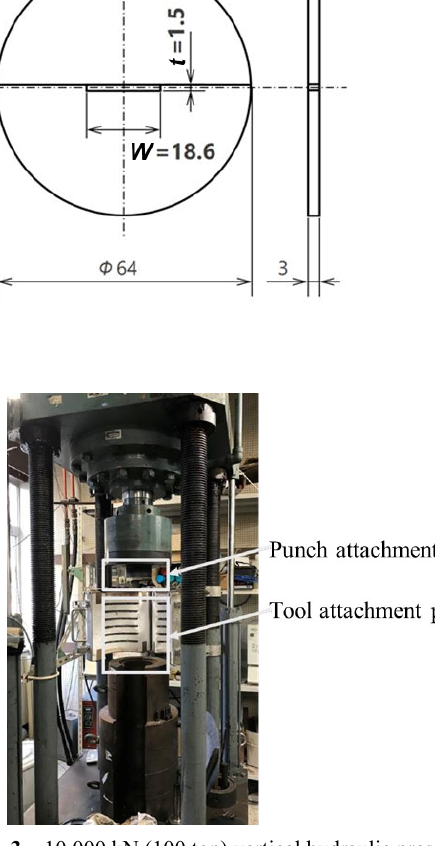
Fig. 3 10,000 kN (100 ton) vertical hydraulic press machine.